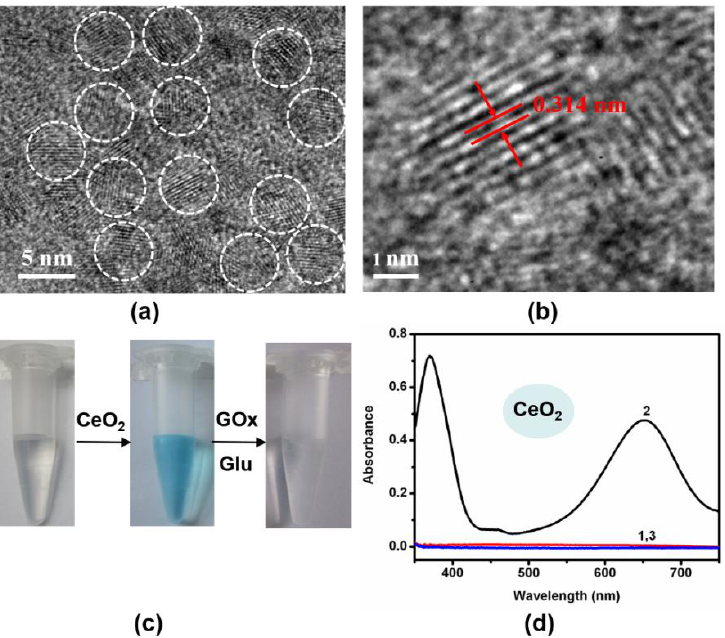
Figure 2. ( a , b ) TEM images of as-synthesized CeO 2 NPs. ( c ) Typical photographs of TMB reaction solutions oxidized by CeO 2 NPs and oxTMB reaction solutions reduced by GOx/glucose. ( d ) UV-vis absorption spectra of TMB reaction solutions in the presence of (1) no reactants, (2) CeO 2 NPs, (3) CeO 2 NPs, glucose, and GOx. ([TMB] = 120 μM, [CeO 2 NPs] = 6 μg/mL, [glucose] = 5 mM, [GOx] = 1 unit/mL, [citrate buffer] = 40 mM, pH 6.0).